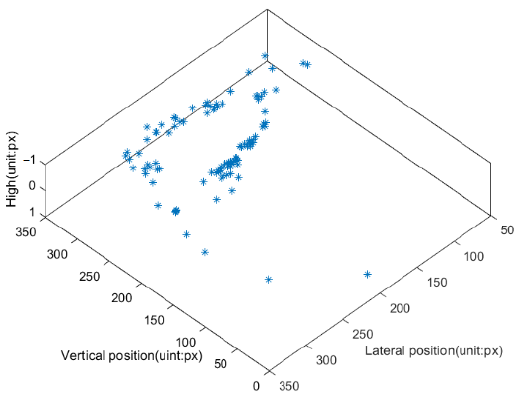
Figure 6. Position of the center of mass during the melting of silicon dioxide.